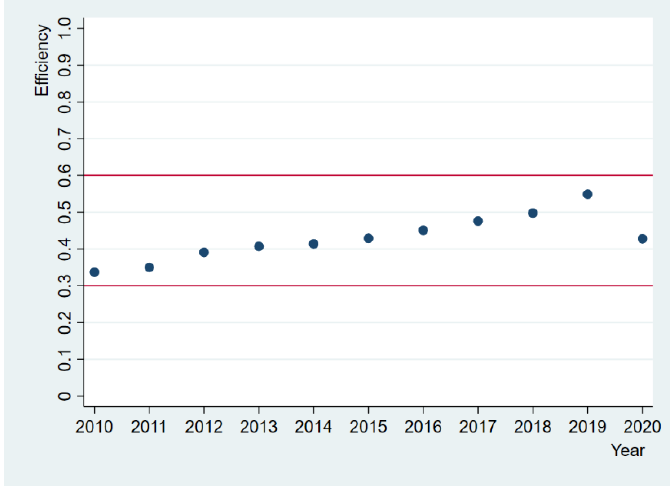
Figure 11. The degree of spatial agglomeration of